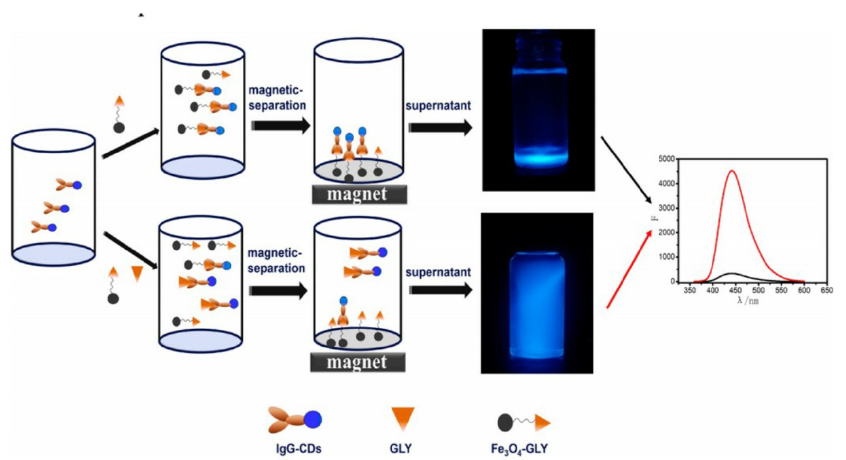
Figure 10. Strategy detection for GLYP using carbon dots coupled to glyphosate antibodies (IgG- CDs and Fe 3 O 4 -GLYP. Reprinted with permission from [127]. Copyright 2016 ACS Publications.